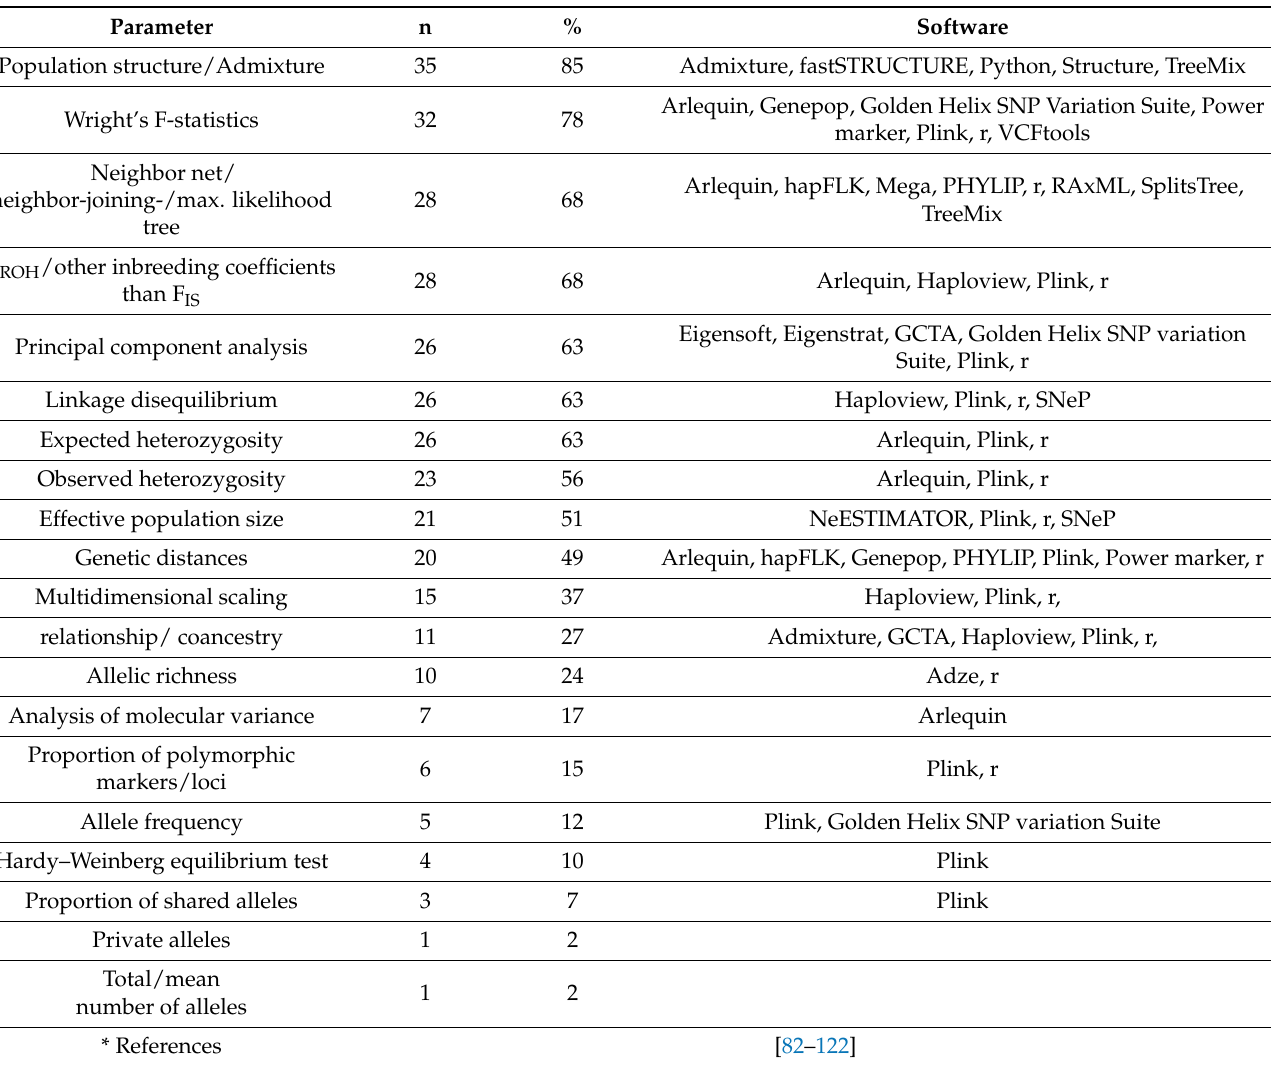
Table 2. Percentage of computed diversity parameters in 41 studies * based on SNP-arrays and respective software programs used (for citations, see Table